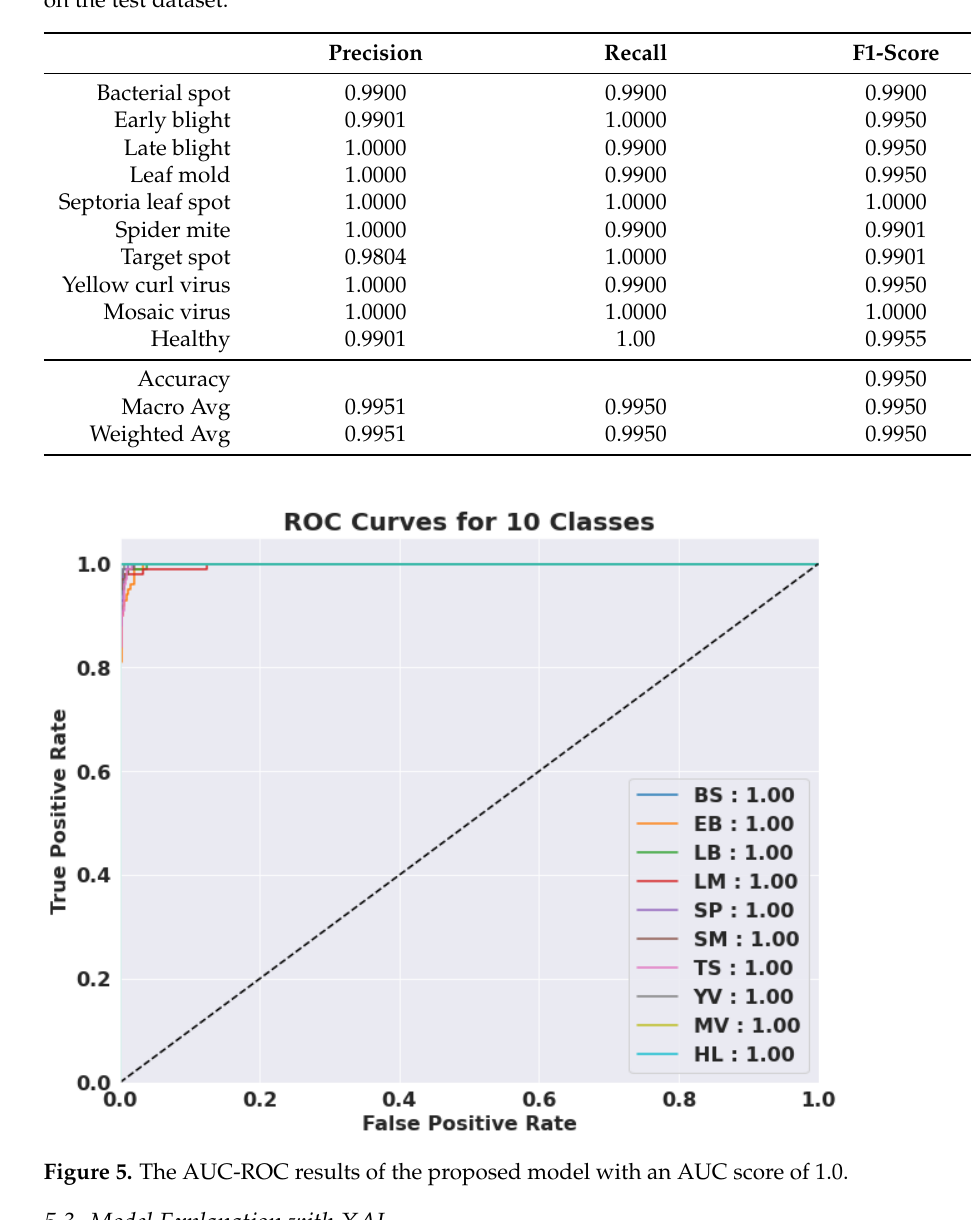
Table 4. Class-wise prevision, recall, F1-score, and support (number of samples) for each TLD class on the test dataset.